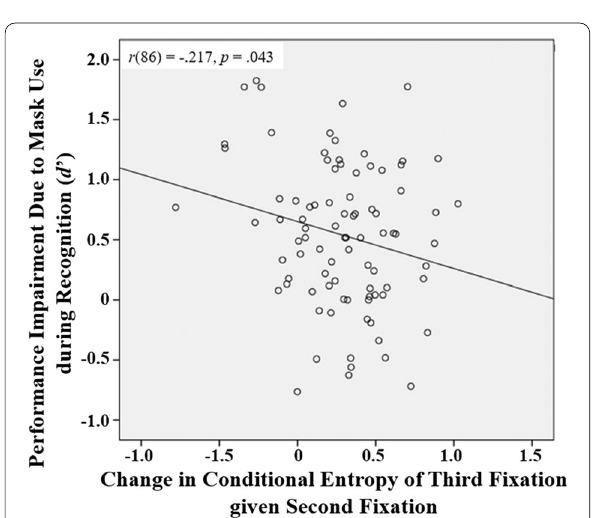
Fig. 5 Correlation between the change in conditional entropy of the third fixation given the second fixation due to mask use during recognition (unmasked–unmasked condition minus unmasked– masked condition; more positive change indicates larger change toward lower entropy and thus more consistent transition with mask use) and the corresponding performance impairment in d ′ : The more change toward low‑entropy/more consistent gaze transition behavior, the less the performance